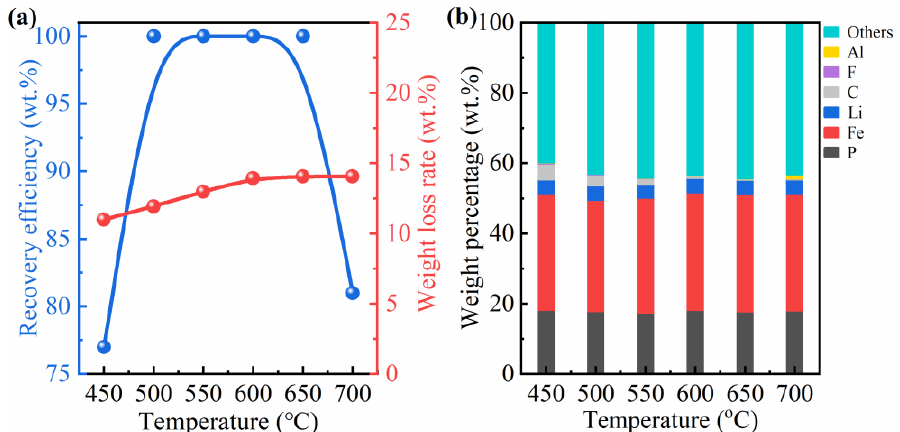
Figure 4. E ff ect of roasting temperature on the ( a ) recovery e ffi ciency of cathode materials, weight loss Figure 4. Effect of roasting temperature on the ( a ) recovery efficiency of cathode materials, weight rate of cathode plates and ( b ) element content in calcined cathode loss rate of cathode plates and ( b ) element content in calcined cathode materials.